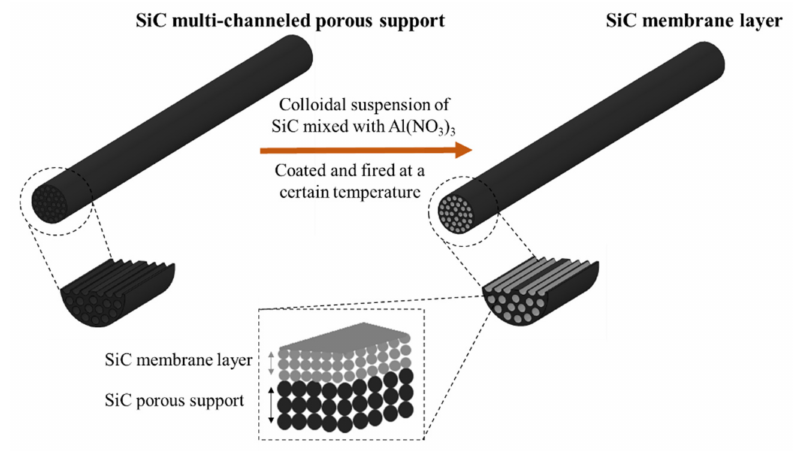
Figure 1. Schematic diagram of the fabrication process for SiC